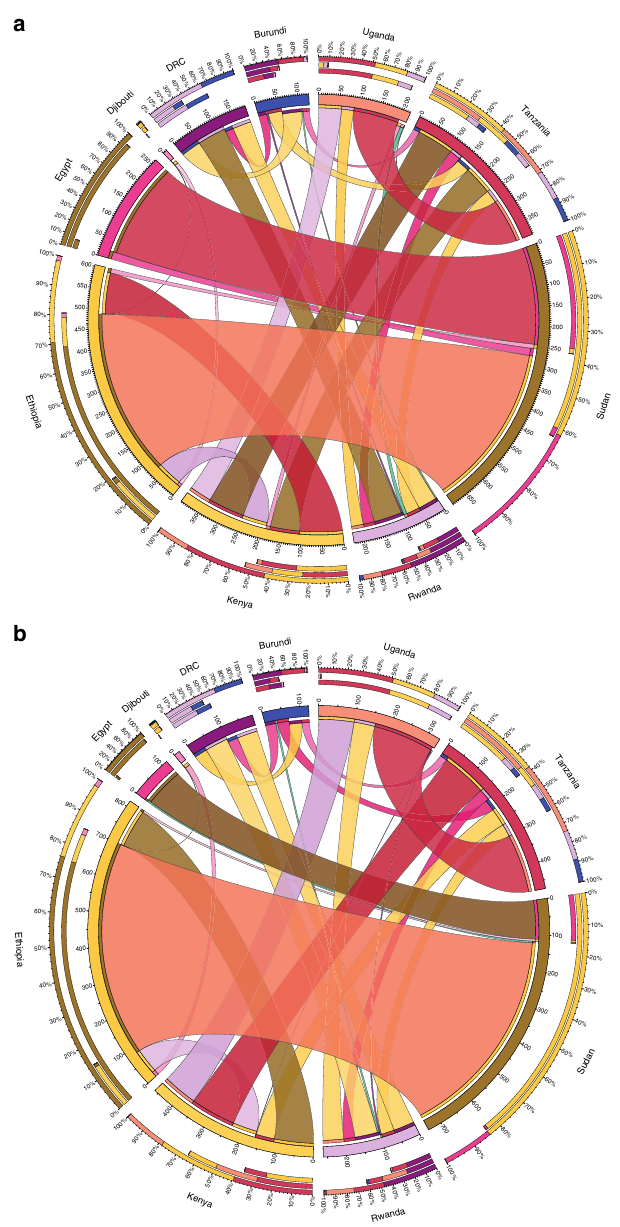
Fig. 5 Electricity trade under perfect foresight strategies. a Cumulative (2017 – 2050) electricity trade under perfect foresight driest climate. b Cumulative (2017 – 2050) electricity trade under perfect foresight wettest climate. The outer circle highlights the different countries of the EAPP. There are three bars (percentage mix) corresponding to the outermost circle. In the order of outermost to the innermost bar, the fi rst refers to the exported electricity; the second refers to the imported electricity and the third to the difference. The colour of the bar (arc), on the inner circle, is speci fi c to the country where electricity is exported or imported from. The scale on the circumference of the inner circle shows the absolute values of electricity trade in TWh. Each fl ow band denotes the cumulatively traded electricity from country A to country B. Flow bands attached to a country ’ s inner circle represent exports from that country and